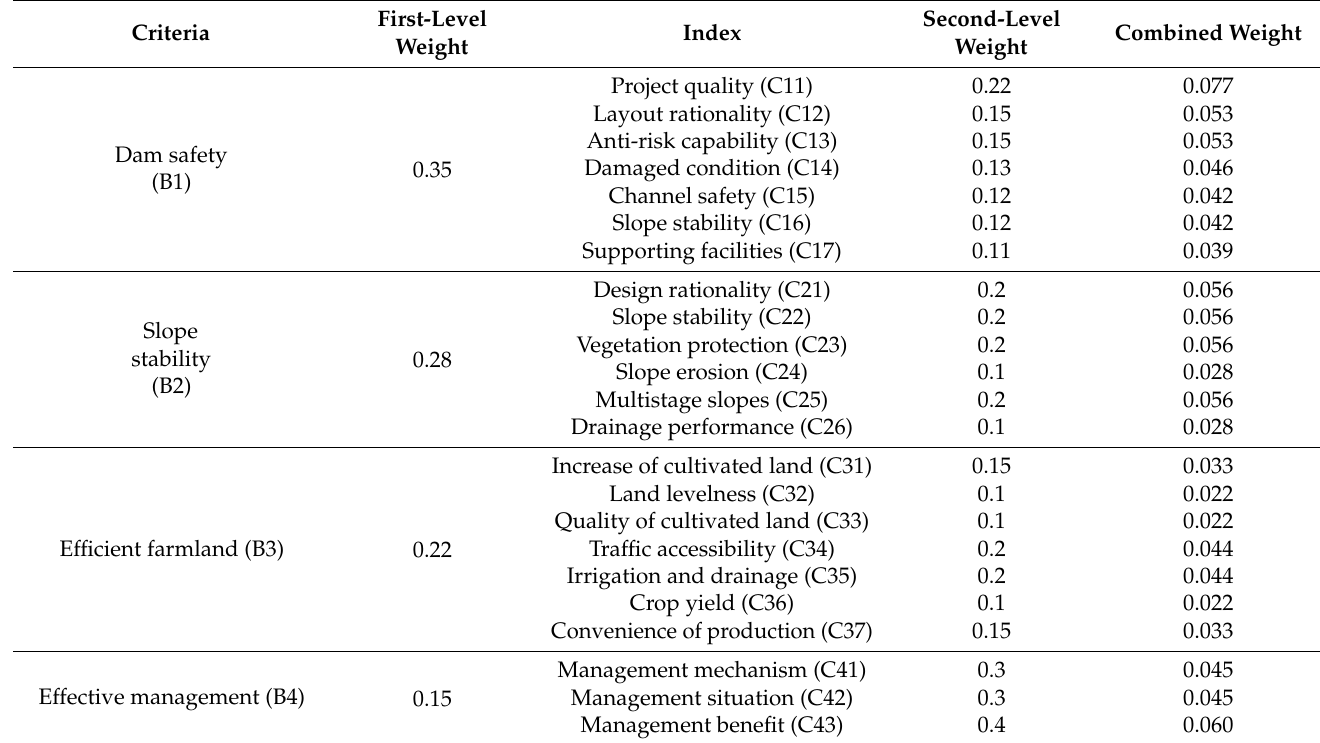
Table 1. Index weight of the evaluation index